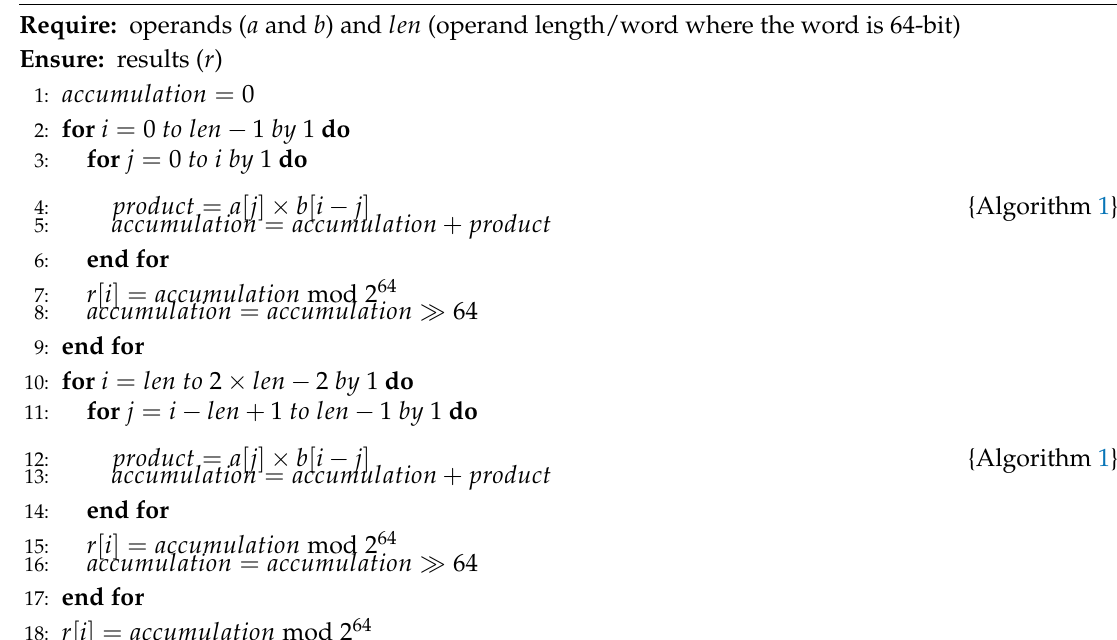
Algorithm 2 64-bit wise scalable product-scanning for